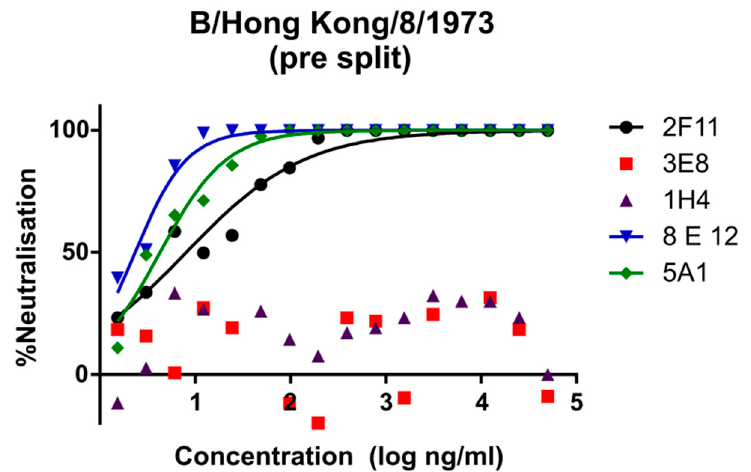
Figure 2. pMN neutralisation curves for FDA mAbs 2F11, 3E8, 1H4, 8E12 and 5A1 against PV bearing the HA glycoprotein from the influenza B pre-lineage split strain, B/Hong Kong/8/1973. This PV is neutralised strongly by Victoria-specific mAbs 5A1, 8E12 and cross-lineage mAb 2F11 but not Yamagata specific mAbs 3E8 or 1H4.